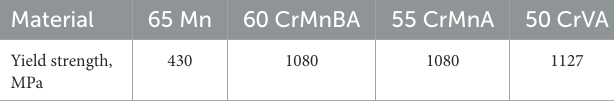
TABLE 1 Available spring steels for the flexible coupler.